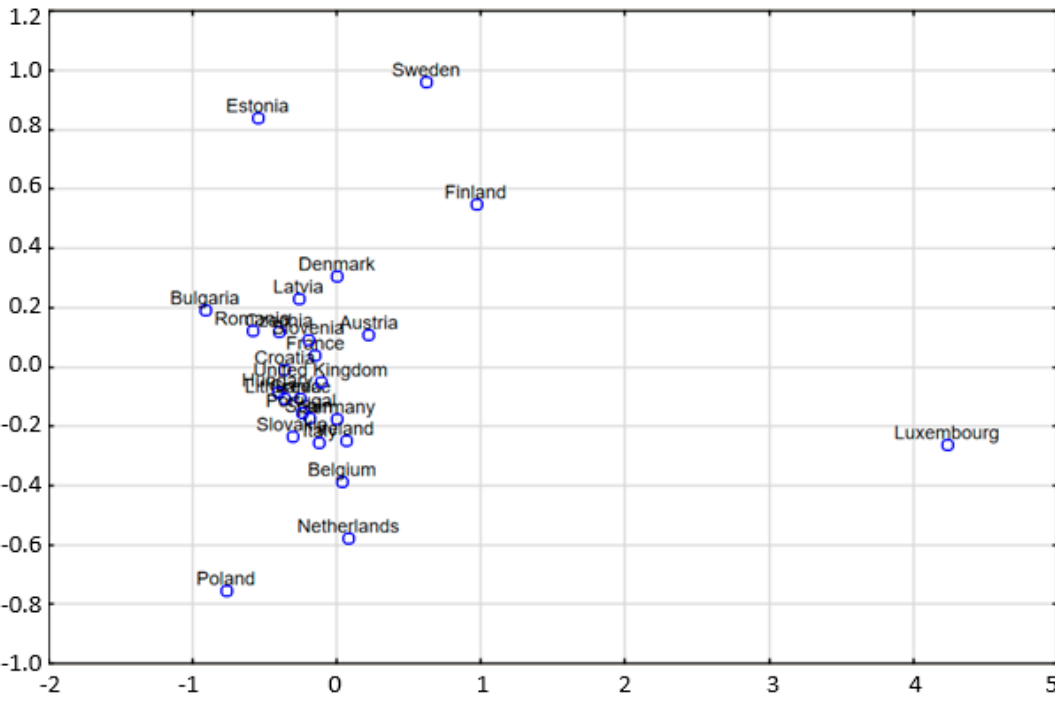
Figure 3. Sustainable development level of energy markets in two-dimensional graph for 2018.